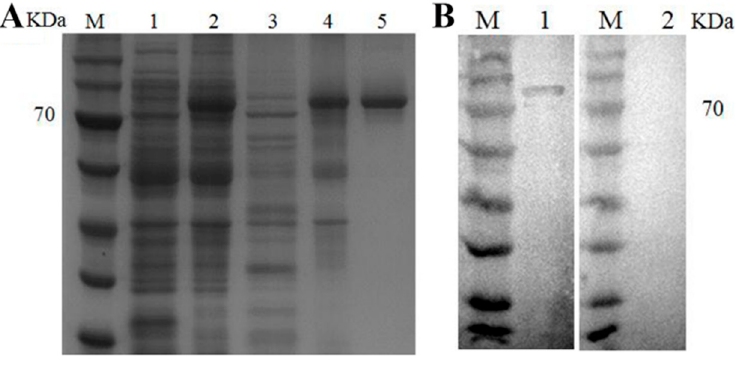
Figure 1. Preparation of polyclonal antibody. ( A ) Recombinant expression of Pv Kelch-like-1. Lane M, protein marker; Lane 1, control group with no isopropyl β -D-thiogalactopy ranoside (IPTG); Lane 2, control group inducted for 2 h with 1.0 mM IPTG; Lane 3, the sample of supernatant; Lane 4, dissolution of precipitation; Lane 5, purified protein; ( B ) Western blot analysis of the polyclonal antibody. Lane M, protein marker; Lane 1, Pv Kelch-like-1 recombinant protein incubated with experimental group serum; Lane 2, Pv Kelch-like-1 recombinant protein incubated with control group serum.